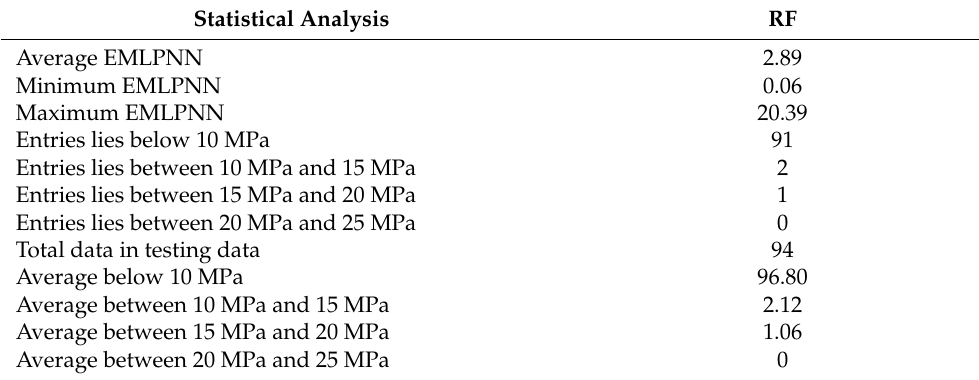
Figure 11. ( a ) Predicted data through RF; ( b ) Error distribution of actual and predictions. Table 8. Statistical analysis of